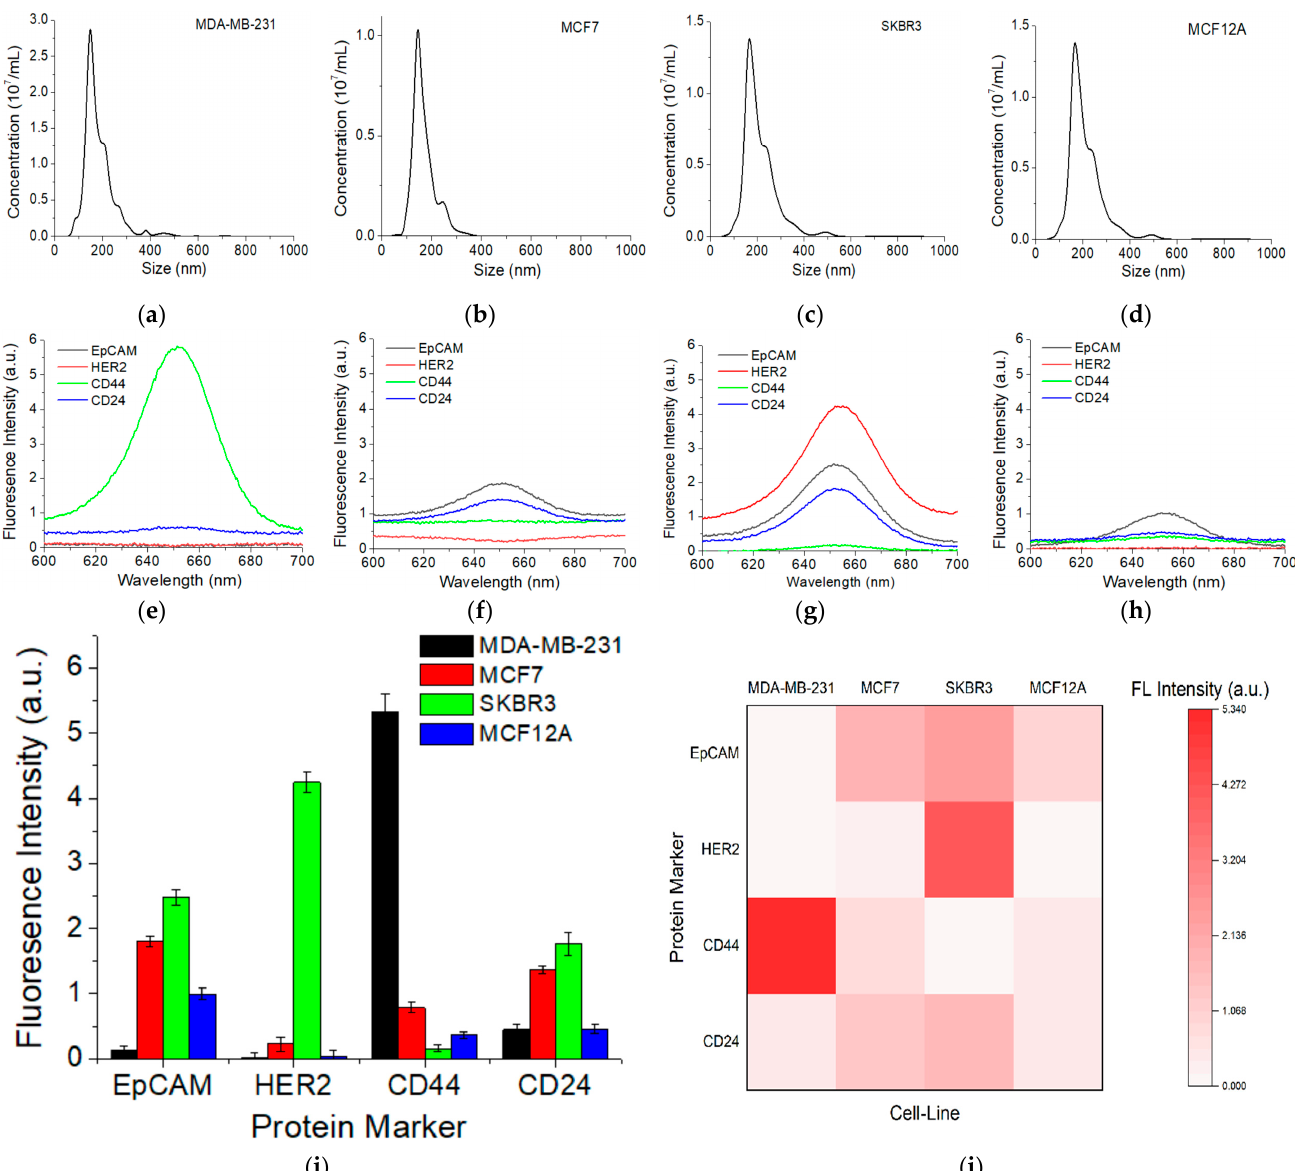
Figure 5. Detection of surface protein markers on EXOs derived from different breast cancer cells (MDA-MB-231, MCF7, and SKBR3) in comparison to normal cells (MCF12A). ( a – d ) Size distribution of EXOs measured with NTA. ( e – h ) Fluorescence spectra of EXOs targeting different surface markers. ( i ) Comparison of protein marker expressions based on the fluorescence mean intensity at 655 nm. The p -values among the four cell-lines for markers EpCAM, HER2, CD44, and CD24 are 2.3 × 10 − 8 , 6.2 × 10 − 10 , 1.3 × 10 − 9 , and 3.0 × 10 − 6 , respectively. ( j ) Heatmap comparison of protein expression based on data in ( i ). Error bar is the standard deviation from tripli- cate experiments.